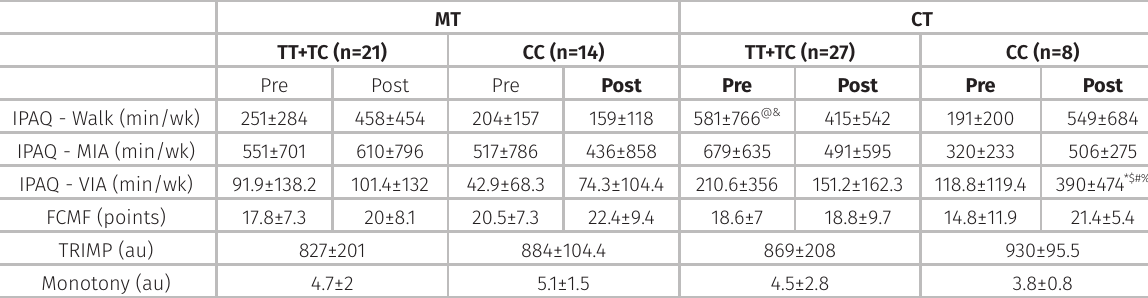
Table VII. Physical activity level, nutritional evaluation, and training load of MT and CT groups related to ACTN3